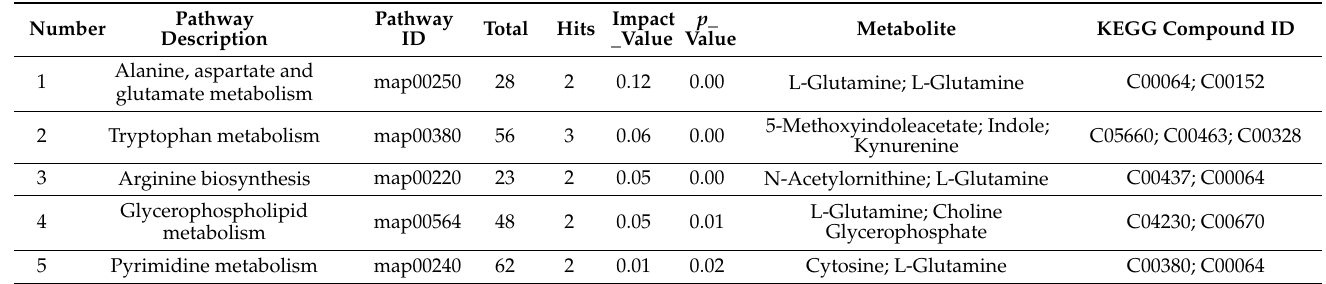
Table 3. Pathway enrichment identification results of Z-2-GS-2-VS-GS group.